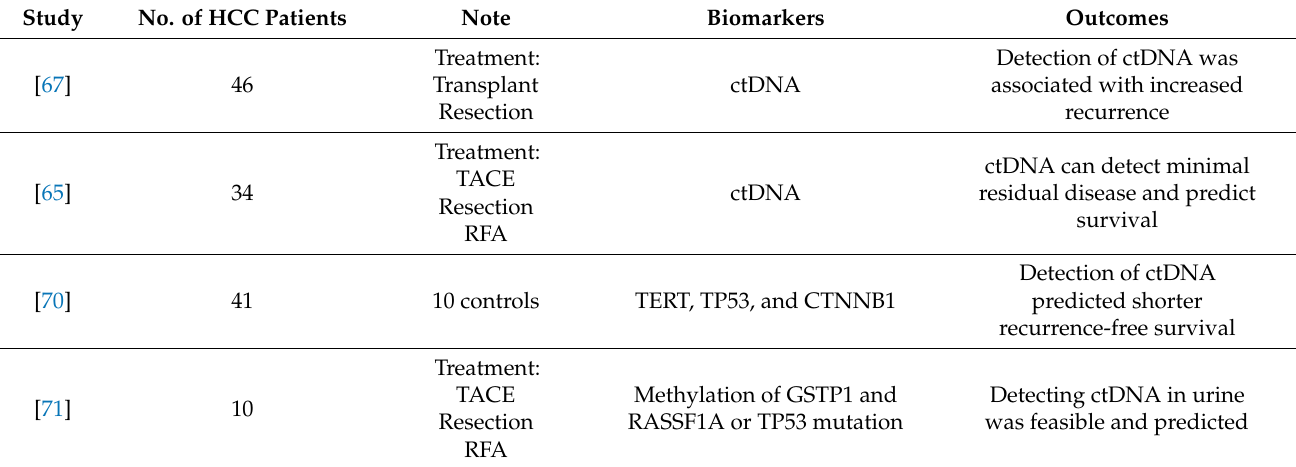
Figure 4. Utility of ctDNA in HCC for minimal residual disease evaluation and surveillance: pros and cons in comparison with tissue biopsy. (+) advantages ( − ) disadvantages. Table 1. Representative circulating tumor DNA studies in